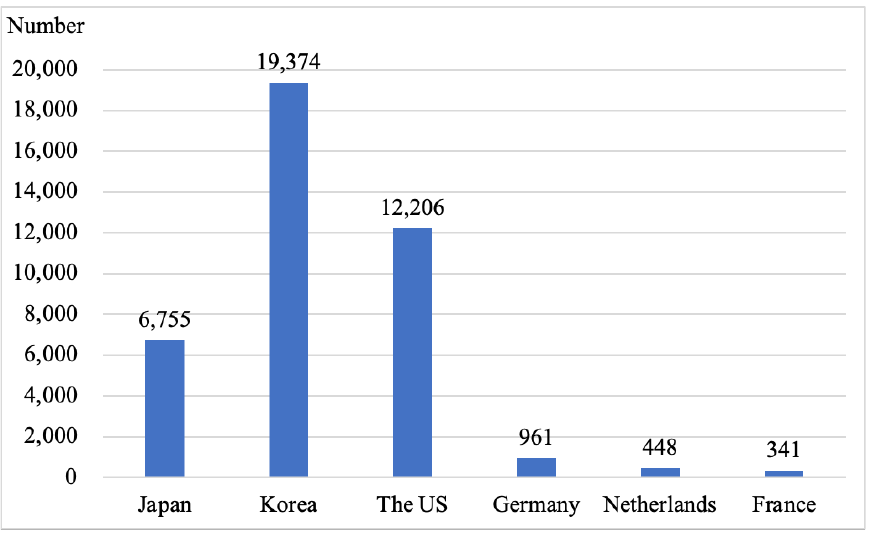
Figure 1. The cumulative sales of fuel cell vehicles.